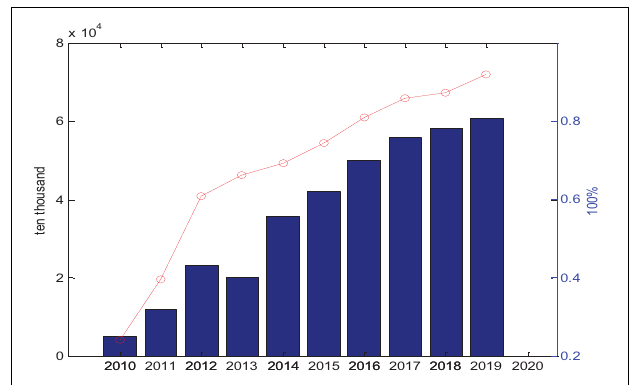
FIGURE 3 | Number and proportion of mobile phone users.